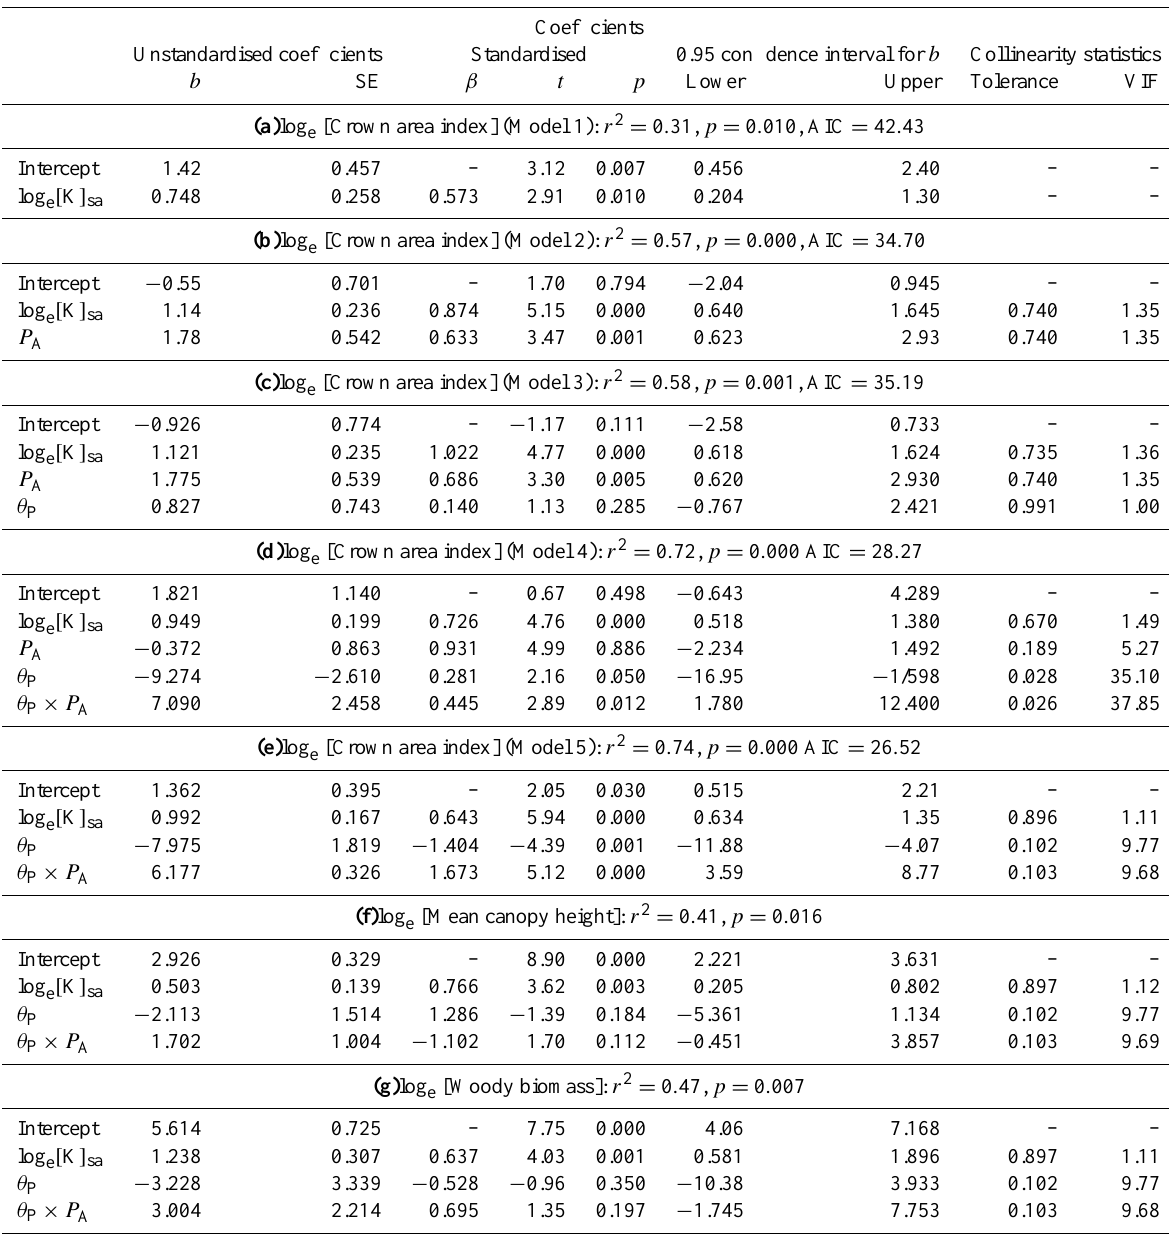
Table 3. Multivariate regression statistics relating canopy area index ( C W ), mean upper stratum canopy height (cid:104) H U (cid:105) , and above-ground biomass ( B U ) to soil and climatic variables. From (a) to (d) occur increasingly complex models for the prediction of C W ; (e) represents an application of model (d) to (cid:104) H U (cid:105) and (f) is model (d) but applied to B U . Other abbreviations: [ K ] sa – soil potassium (mmolm − 2 ), P A mean annual precipitation (m), VIF – variance inflation factor. In all cases predictor variates have been centred with the unstandardised intercept giving then the predicted value when all predictor variables are at their mean values. In the standardised case, all variables have been centred and scaled by their